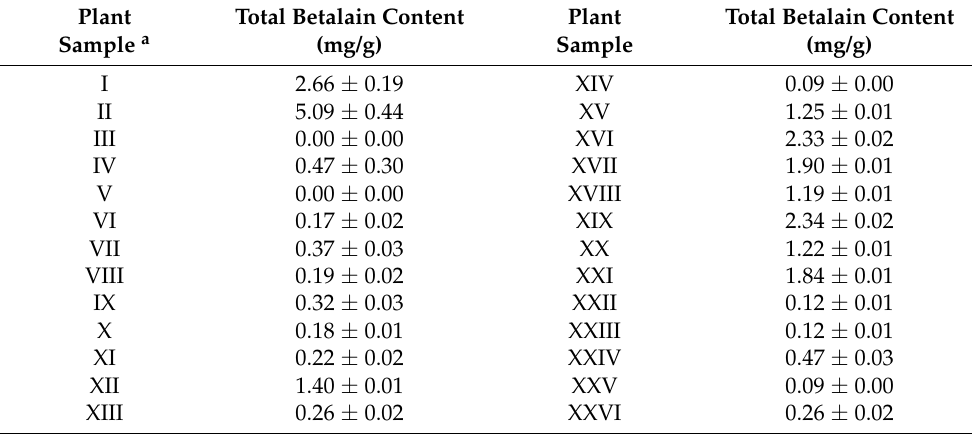
Table 3. Total betalain content of Epiphyllum , Hylocereus , and Opuntia fresh